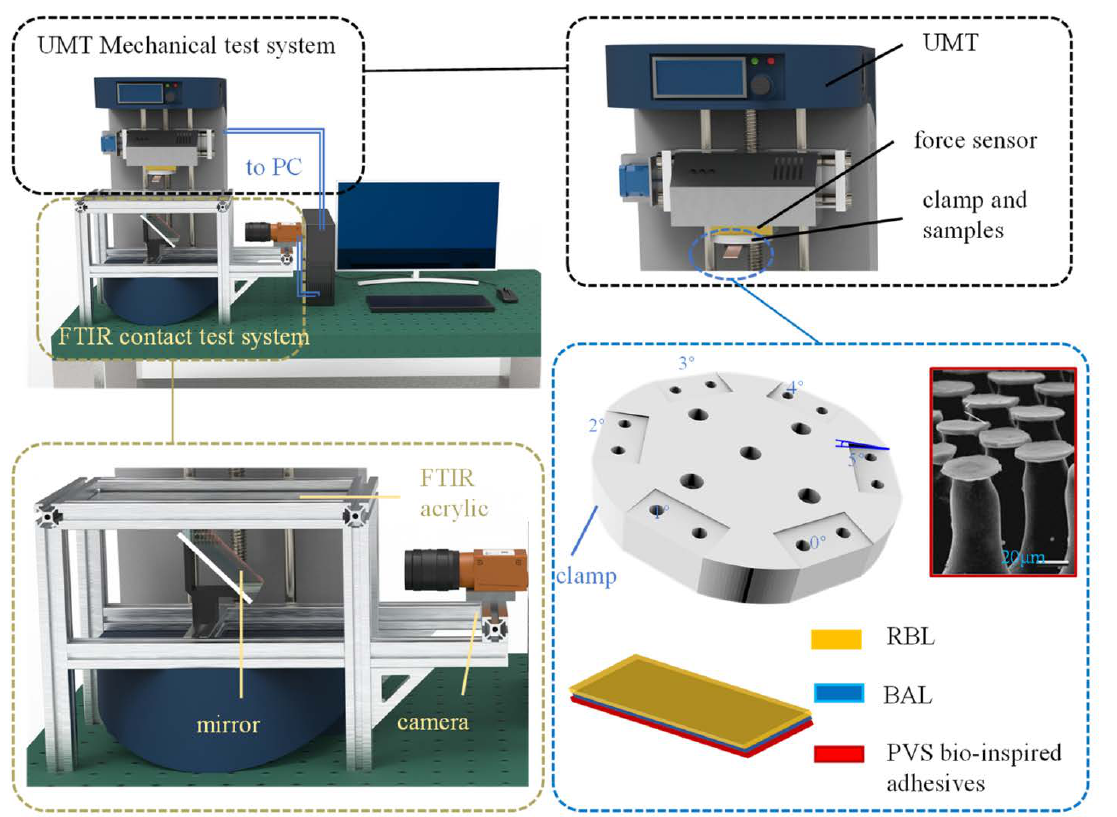
Figure 4. The synchronized testing platform for testing the adhesive contact state and